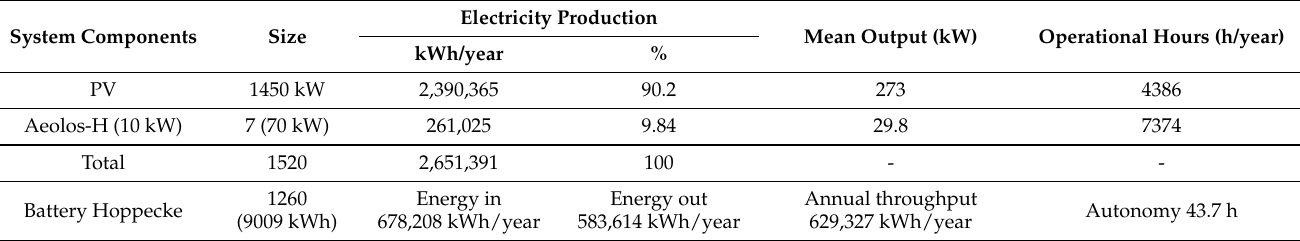
Table 22. Analytical Electrical Production and technical characteristics for optimal configuration of Scenario 3 case 1.